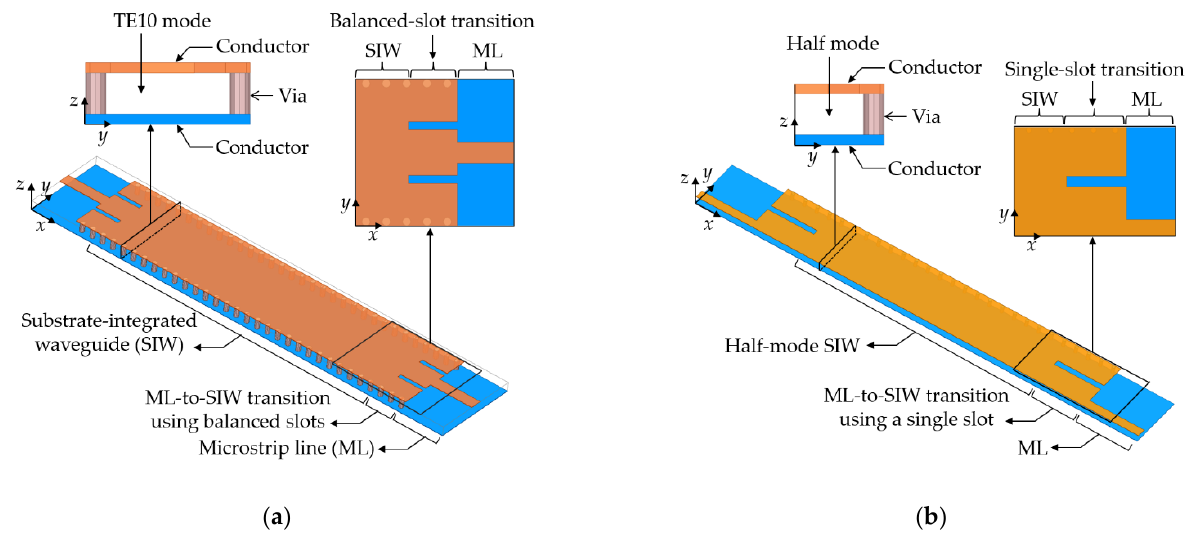
Figure 1. Back-to-back configurations of the mmWave SIWs including a slot transition technique. ( a ) FMSIW based on TE 10 mode propagation; ( b ) HMSIW based on half mode (TE 0.5,0 ) propagation.